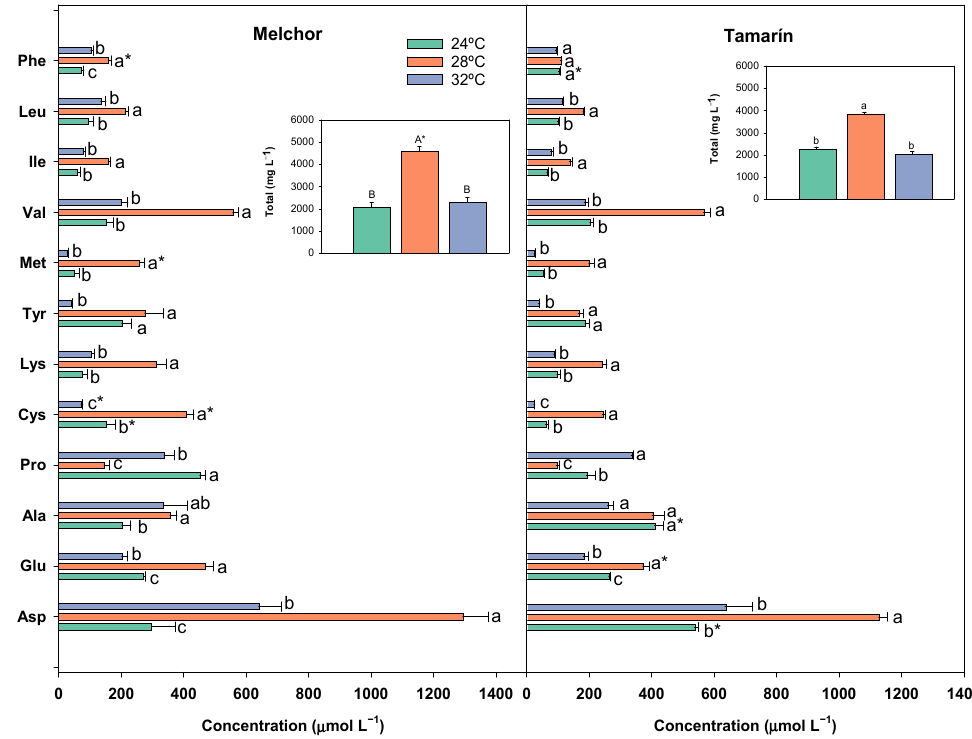
Figure 6. Effect of temperature (24 °C, 28 °C, and 32 °C) on amino acid concentrations of Melchor and Tamarín fruits. The data are presented as the treatment means ( n = 6) ± S.E. Different lowercase letters indicate significant differences between temperatures in Melchor and different uppercase letters indicate significant differences between temperatures in Tamarín. * Denotes significant differences between two cultivars grown under the same temperature conditions.